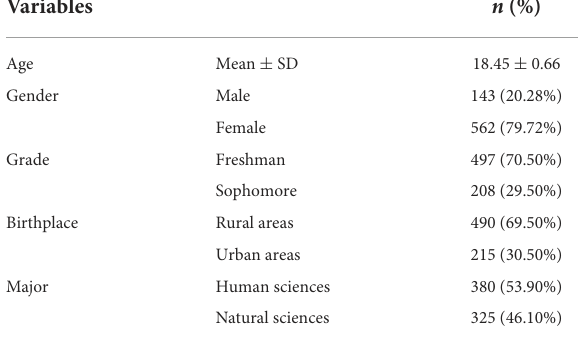
TABLE 1 Basic characteristics of